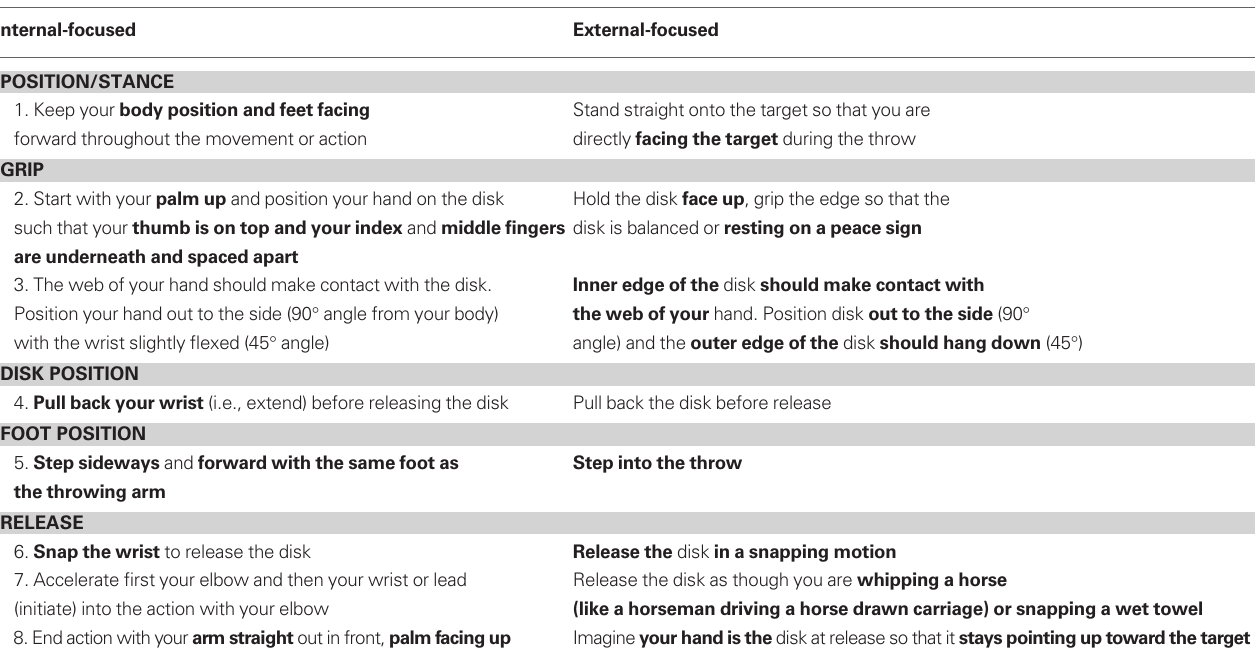
Table 1 | The eight internal-focused (experiment 1) and external-focused (experiment 2) instructions for the forehand Frisbee throw. internal-focused external-focused